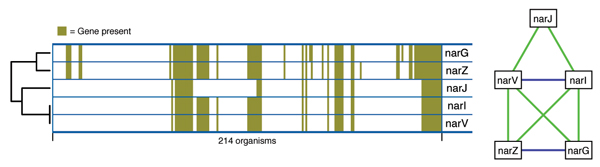
Nitrate reductase subnetwork. We show a small cluster that is present in the runs-informed network and absent in the unweighted hypergeometric network that does not use runs. The phylogenetic profiles of the corresponding genes are shown in (a). Significant edges are shown in (b) with blue edges being identified by both methods while green edges belong only to the runs-informed network. We note that the only elements of this network detected by the non-runs-using method are two highly homologous nitrate reductase complex subunits; the other members are less homologous and are missed by it. Even though these genes occur in relatively few genomes, those in which they occur are widely scattered and form many runs in the profiles, leading to their correct inclusion in the runs-informed network.